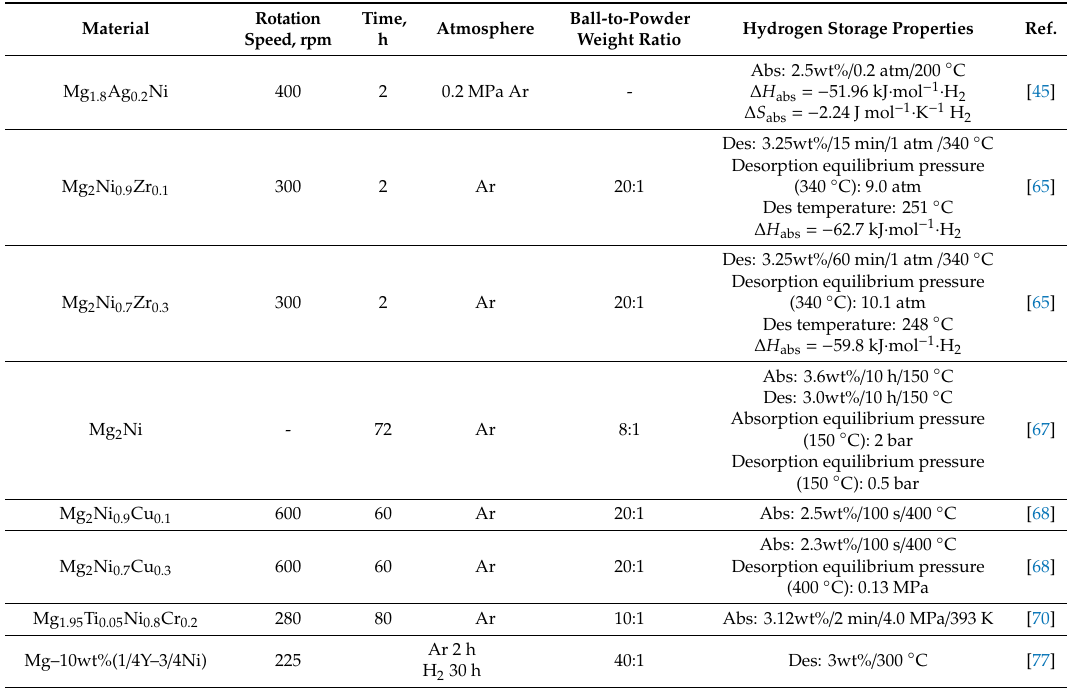
Table 1. Hydrogen storage properties of various Mg 2 Ni alloys modified by element